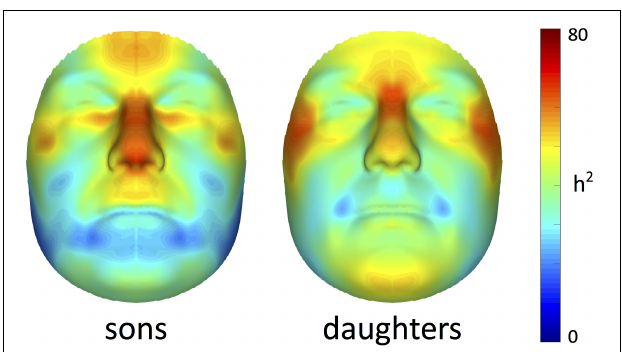
FIGURE 1 | Facial heritability maps. 3D landmark heritability (%) for sons and daughters as obtained from the regression on fathers. The red-blue spectrum represents regions of high and low heritability, respectively. The maximum value was set to 80% for visualization